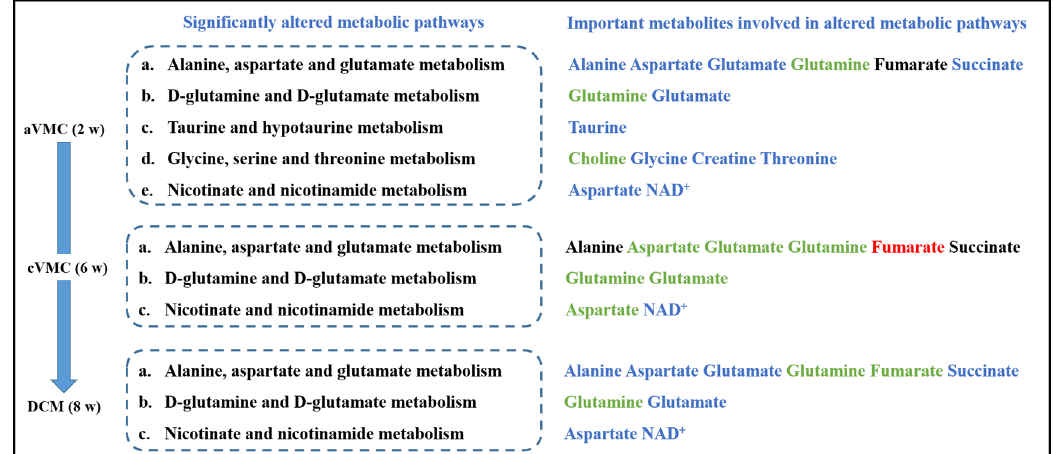
Figure 3. Schematic representation of significantly altered metabolic pathways associated with the three pathological stages compared with normal stages. Red, blue and black colors represent significantly increased, decreased and substantially unchanged metabolites; green colors denote the metabolites with the changing trends without statistically significance.